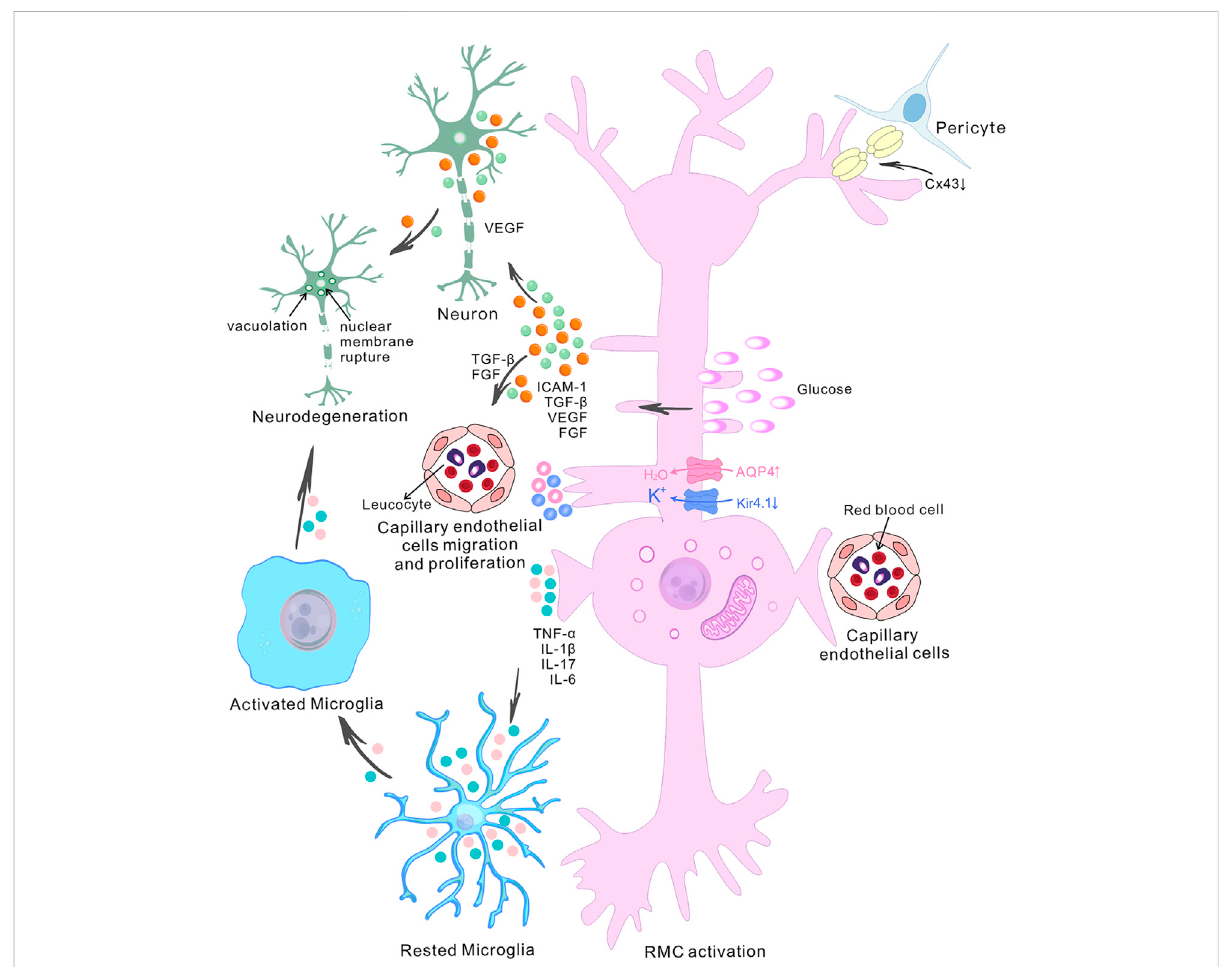
FIGURE 2 The role of retinal Müller cells in the pathogenesis of diabetic retinopathy. The diagram shows the central role of retinal Müller cells (RMCs) in various pathophysiological events in diabetic retinopathy (DR) and depicts the interactions between RMCs, capillary endothelial cells, pericytes and neurons. High glucose-induced RMC activation and Connexin43 downregulation in pericytes and Müller cells ultimately lead to accelerated retinal celldeath.Theaccumulation ofwaterandionsinRMCsisapathogenic factorinvolvedinretinaldegenerationduringDR.Ithasbeenfoundthat there is upregulation of aquaporin 4 (AQP4) and down-regulation of the inwardly-rectifying potassium channel 4.1 (Kir4.1) in diabetes. Abnormally- activated RMCs produce pro-in fl ammatory mediators such as TNF- α , IL-1 β , IL-17 and IL-6, and growth factor such as TGF- β , VEGF and FGF. The release of VEGF by RMCs exacerbates retinal neurodegeneration, and the release of TGF- β and FGF induces the migration and proliferation of capillary endothelial cells. Increased pro-in fl ammatory cytokines contribute to microglial activation. Activated microglial also produce increased levels of pro-in fl ammatory molecules, which then induce neuronal degeneration, altogether contributing to the development of